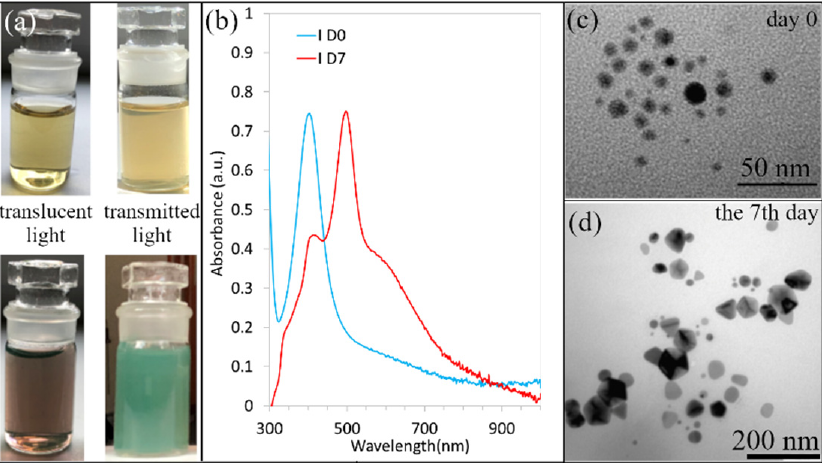
Figure 3. The AgNPs coloids solution I on day 0 (yellow solutions) and 7th day (brown and green solutions) ( a ); UV-vis of the solution I on day 0 and 7th day ( b ); and the TEM images of AgNPs of colloidal solution I on day 0 ( c ) and on the 7th day ( d ).